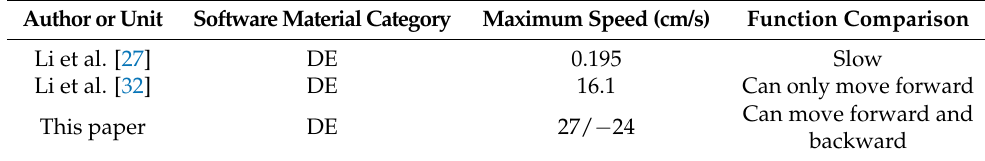
Table 1. Comparison of land running speed with other soft